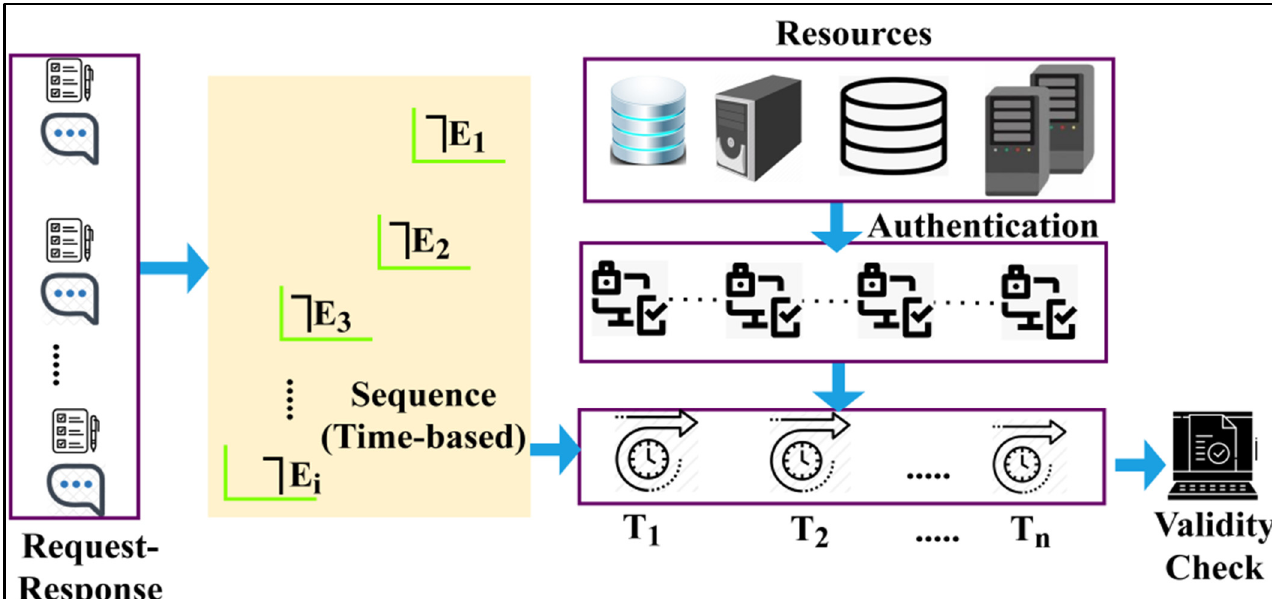
Figure 2. Synchronisation mapping process.